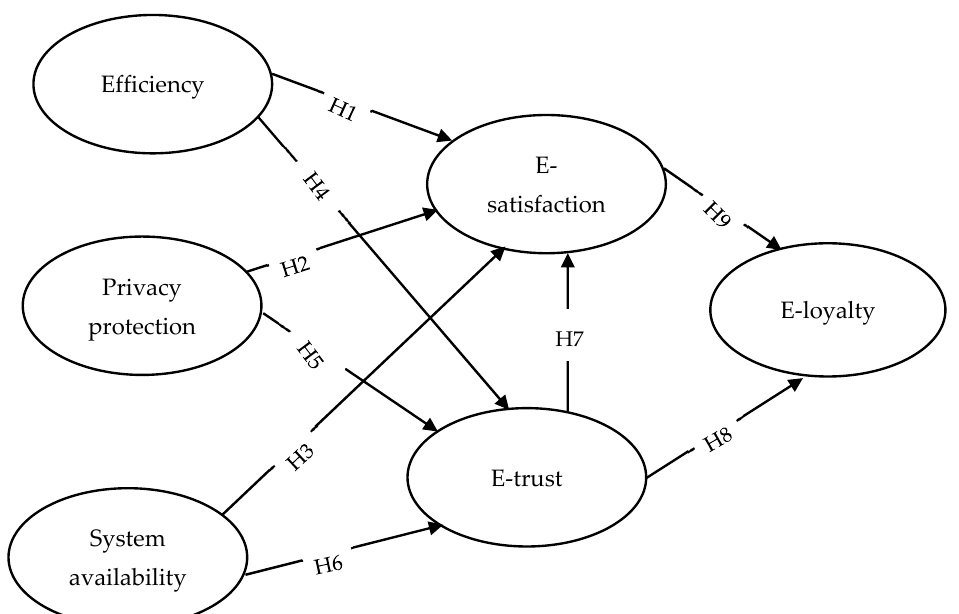
Figure 1. The research theoretical model (please note that the hypotheses in the model are only the direct relationships; indirect relationships are also examined in this research).